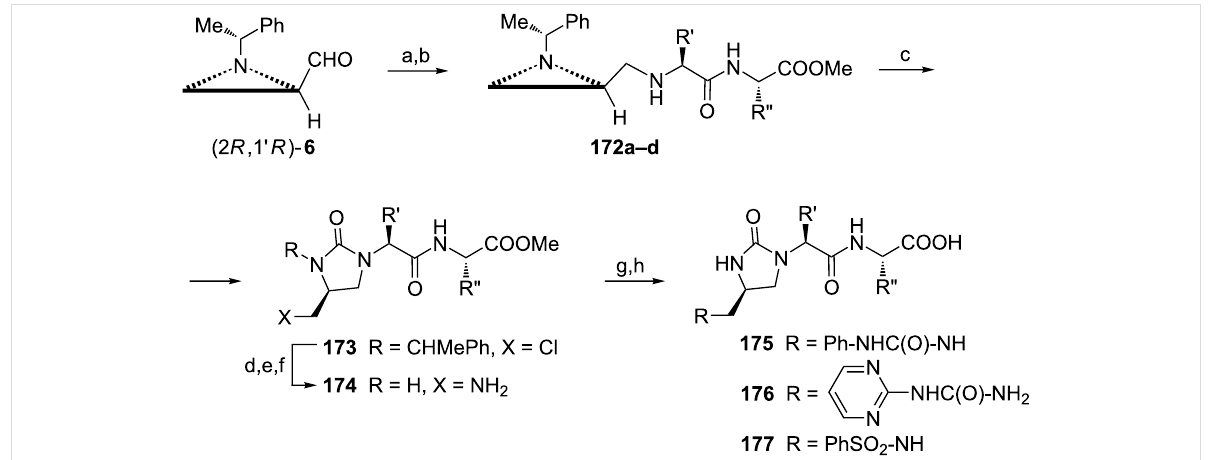
Scheme 44: Syntheses of a series of imidazolin-2-one dipeptides 175 – 177 (for R' and R'' see text). Reagents and conditions: a) H 2 NCHR'C(O)NHCHR''COOMe, MgSO 4 , CH 2 Cl 2 , rt, 5 h; b) NaBH 3 CN, MeOH, rt, overnight; c, triphosgene, NaH, THF, − 10 °C, 2 h; d) MsOH, anisole, hexane, reflux, 4 h; e) NaN 3 , DMF, 80 °C, overnight; f) H 2 , Pd/C, MeOH, rt, overnight; g) PhNCO, THF, rt, 3 h or phenyl (pyrimidin-2- yl)carbamate, MeCN, reflux, 3 h or PhSO 2 Cl, TEA, THF, reflux, 1 h; h) NaOH 1N, MeOH/H 2 O, rt, 1 h.